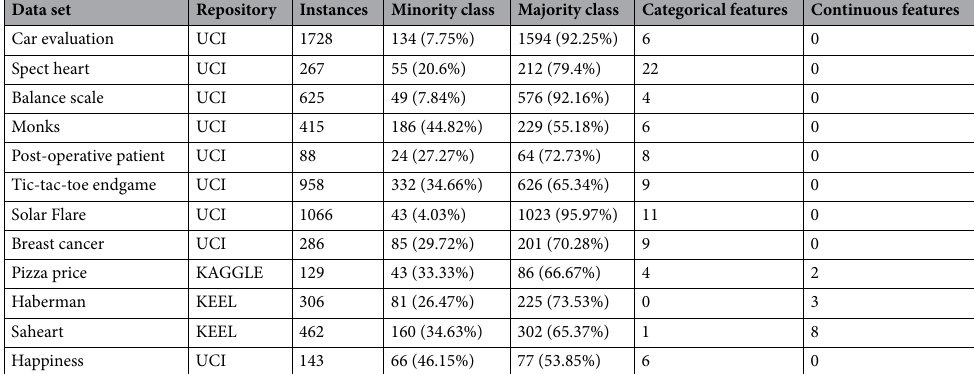
Table 1. Summary of data sets. For the data set Car evaluation , the categories good and v-good on one side, and acc and unaccc on the other, were merged. For Solar flare , we have taken the second data section flare.data2 as the data set as it seems to be more reliable. In Pizza price , extra-cheese has been taken as output class